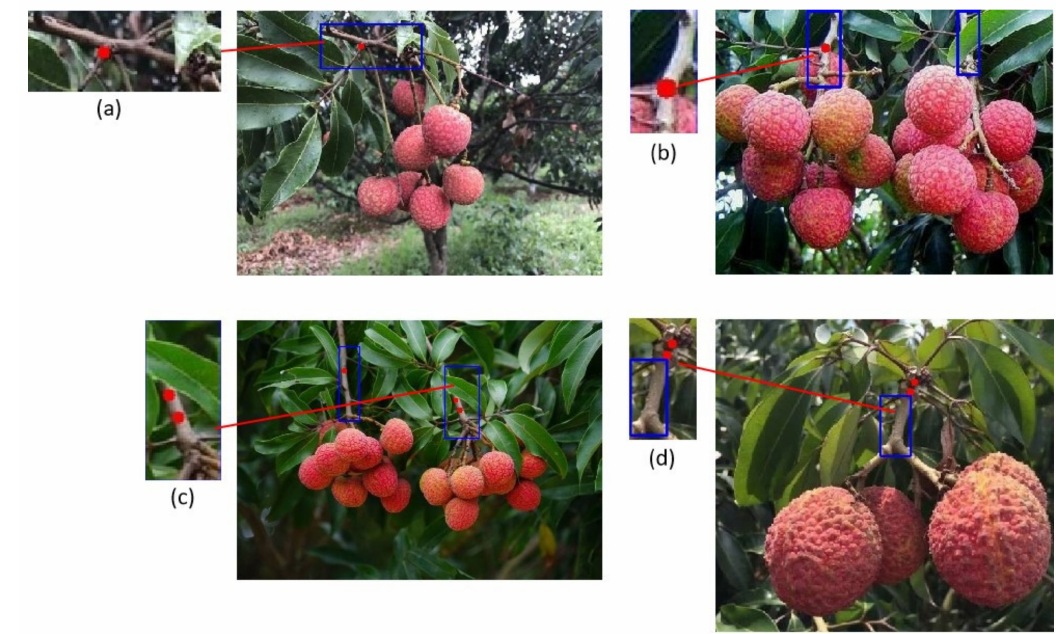
Figure 10. Detection performance of different picking points. ( a ) Although the picking point is not on the main stem, it is next to the main stem; ( b ) The picking point is on the main stem, but it is too close to the litchi fruit; ( c ) Two picking points satisfying the conditions were obtained on the same main stem; ( d ) Although the picking point obtained is not in the main stem detection box, it is still on the main stem.